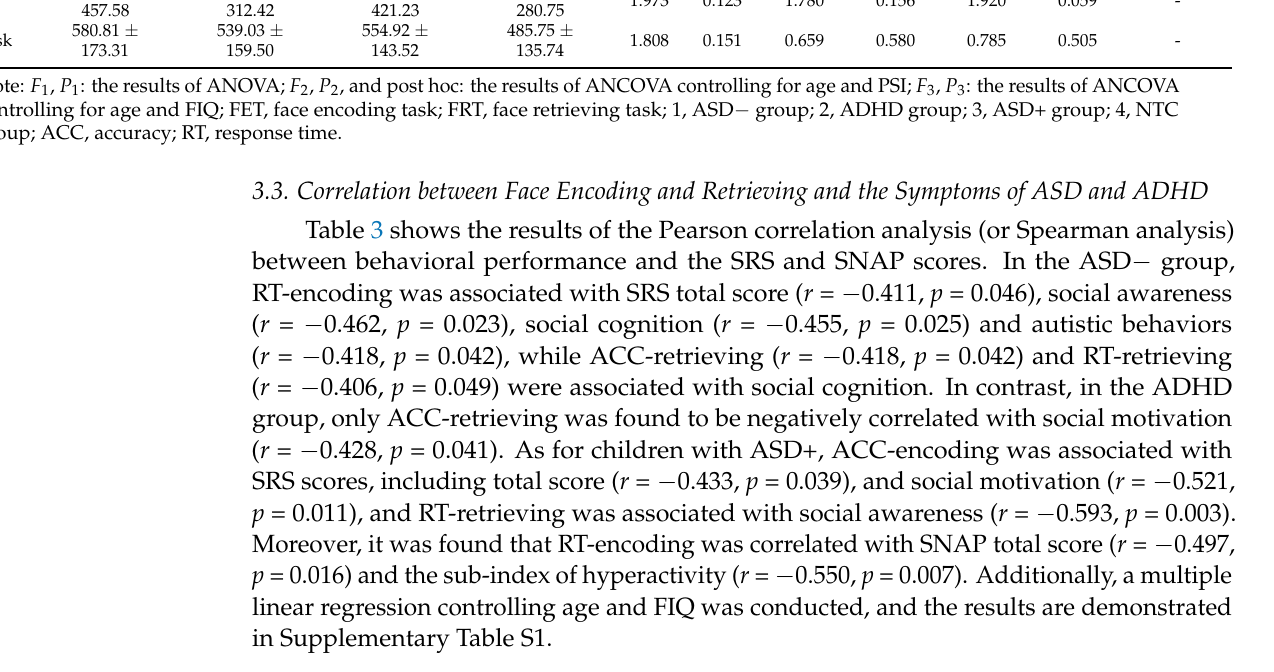
Table 3. Correlation between face memory performance and symptoms of ASD and